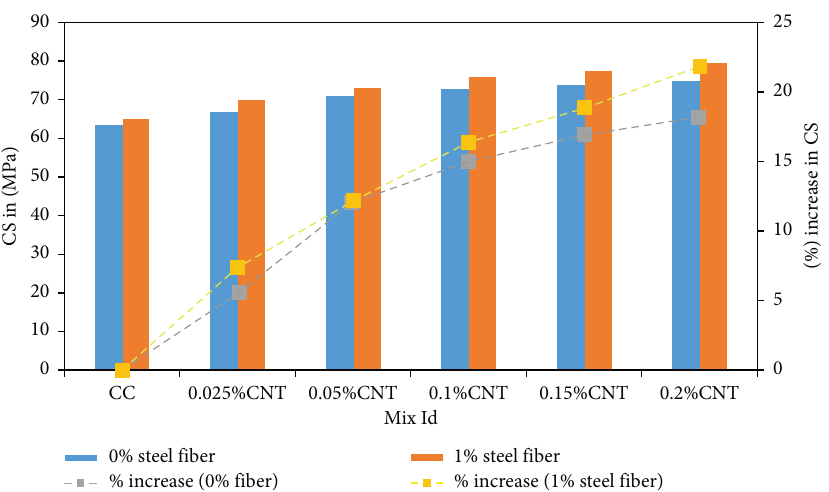
Figure 8: Comparison of compressive strength with and without fbre for